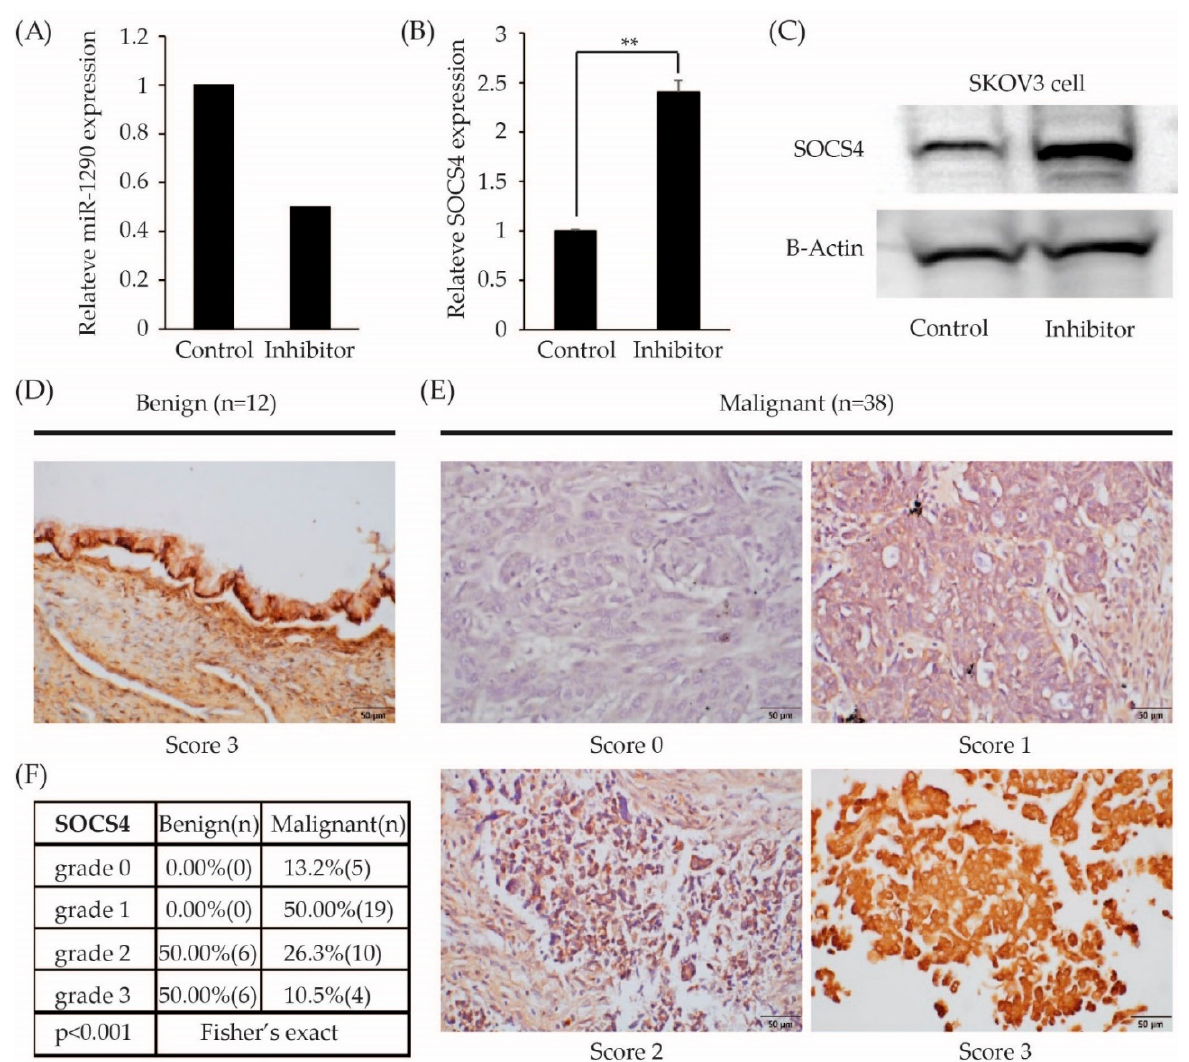
Figure 5. SOCS4 was a target of miR-1290. ( A ) The miR-1290 expression level was decreased after treatment of miR-1290 inhibitor in SKOV3 cell lines by RT-qPCR. ( B , C ) SOCS4 expression was increased in miR-1290 inhibitor treated SKOV3 cells by RT-qPCR and Western blot. B-Actin was used as the loading control. Representative images of nuclear SOCS4 immunohistochemistry staining in EOC and benign ovarian neoplasm (scale bar = 50 µm). ( D ) Benign ovarian neoplasm and ( E ) Ovarian cancer, detection of SOCS4 protein expressions in patients’ tissues via immunohistochemistry method. ( F ) The expression level of SOCS4 in ovarian cancer tissues is significantly decreased compared with that of benign ovarian tumor. SOCS, suppressor of cytokine signaling. ** p <